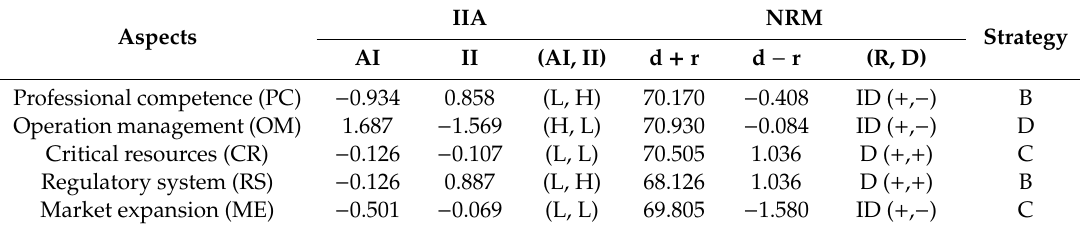
Table 11. The improvement strategy for digital transformation.